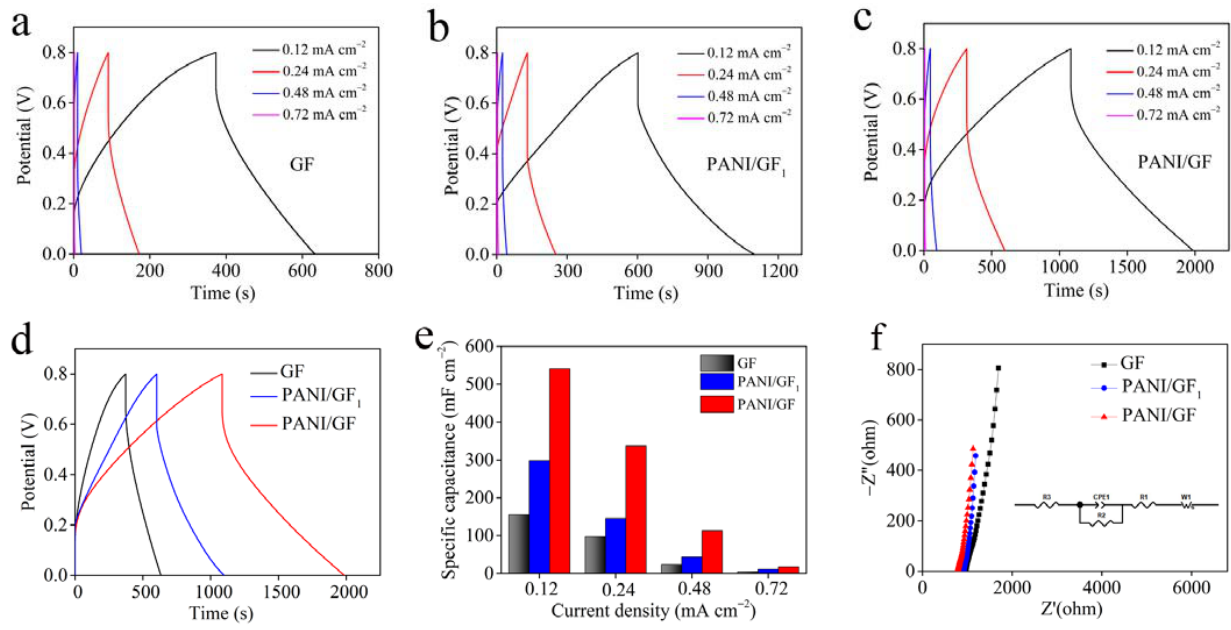
Figure 6. Electrochemical properties of GF, PANI/GF 1 and PANI/GF in a two ‐ electrode system measured using gel ‐ state PVA/H 2 SO 4 electrolyte. Galvanostatic charge ‐ discharge (GCD) curves of ( a ) GF, ( b ) PANI/GF 1 and ( c ) PANI/GF at various current densities of 0.12, 0.24, 0.48 and 0.72 mA cm − 2 ; ( d ) GCD curves of GF, PANI /GF 1 and PANI/GF at 0.12 mA cm − 2 ; ( e ) specific areal capacitances of GF, PANI/GF 1 and PANI/GF at various current densities, ranging from 0.12 to 0.72 mA cm − 2 ; ( f ) EIS analysis of GF, PANI/GF 1 and PANI/GF. Inset: equivalent circuit model.